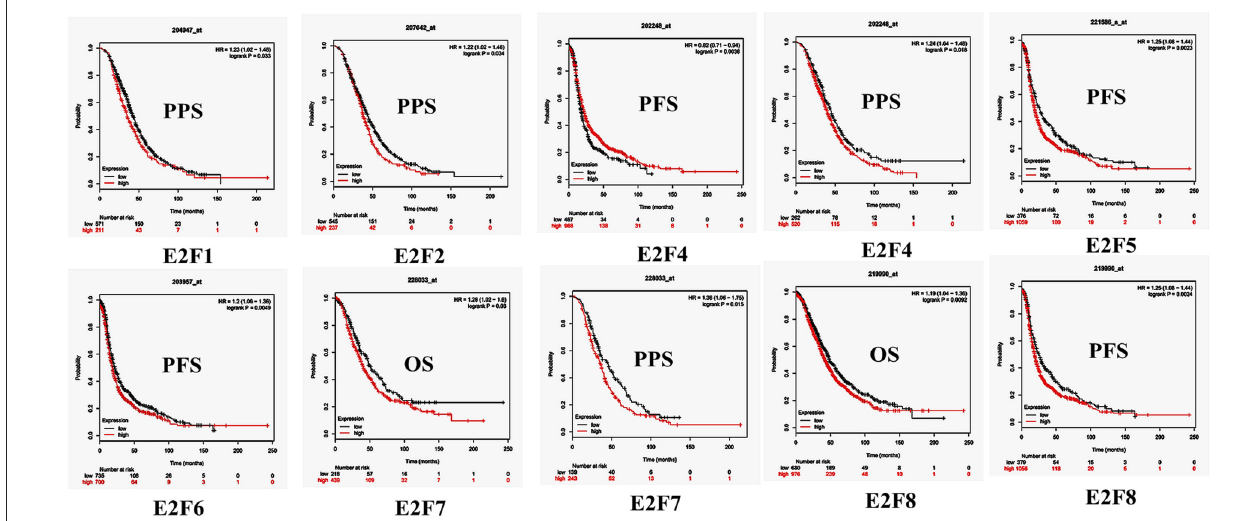
FIGURE 7 | The prognostic value of mRNA level of E2F family members in OC patients (Kaplan–Meier plotter). The OS, PFS, and PPS survival curves comparing patients with high (red) and low (black) E2F family member expression in OC were plotted using Kaplan–Meier plotter database at the threshold of p -value of < 0.05.